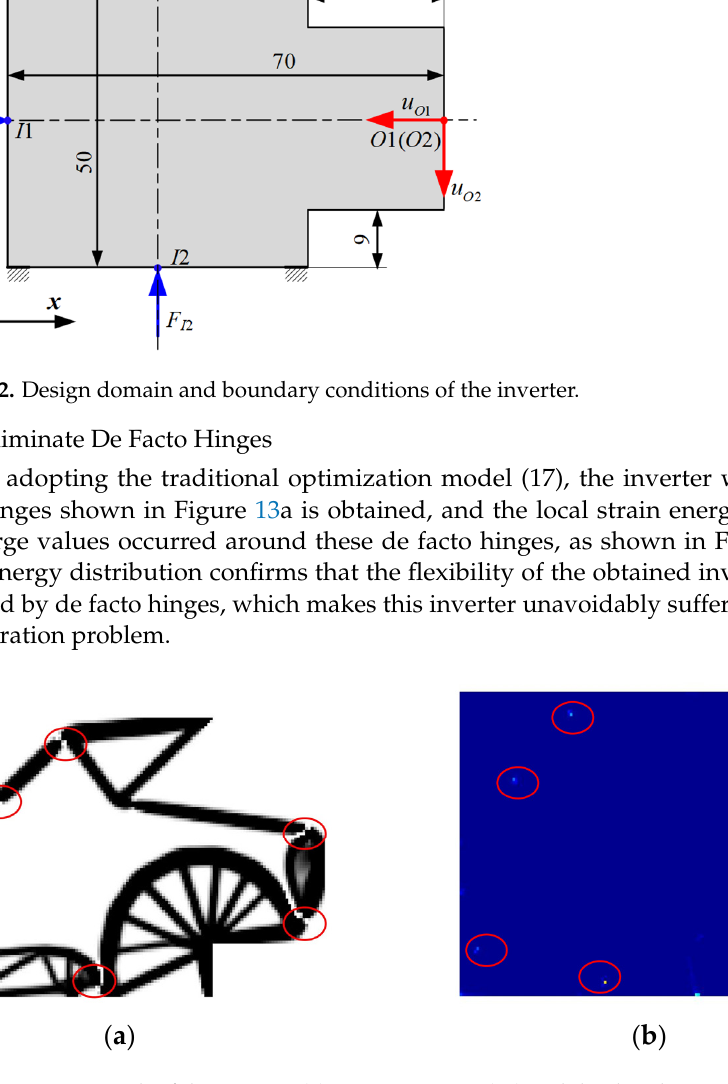
Figure 13. Design result of the inverter ( a ) using Equation (17) and the distribution of the local strain energy density ( b ).